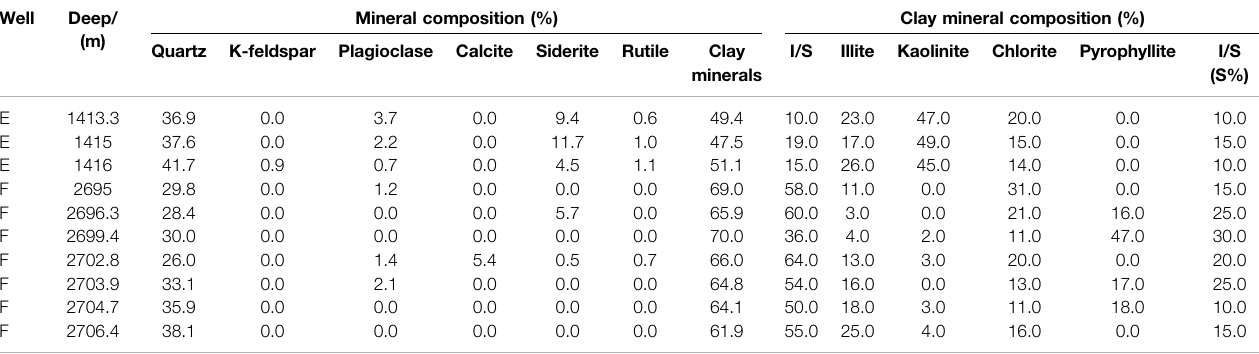
TABLE 1 | Mineral composition of Shanxi Formation shale samples. Well Deep/ Mineral composition (%) Clay mineral composition (%) (m) Quartz K-feldspar Plagioclase Calcite Siderite Rutile Clay minerals